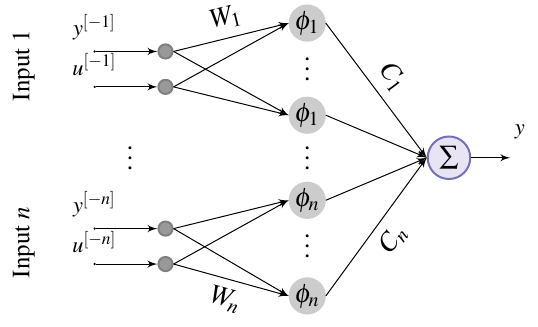
Fig. 1. Neural network with ANARX